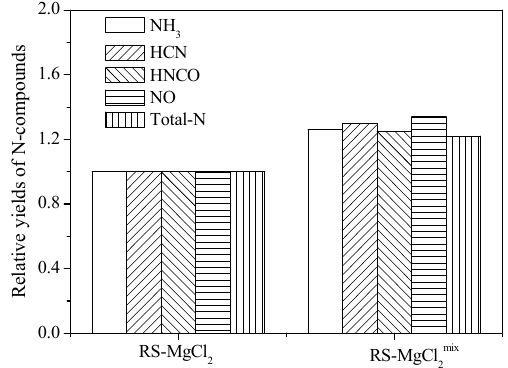
Figure 8. Relative yields of N ‐ compounds for different adding methods.